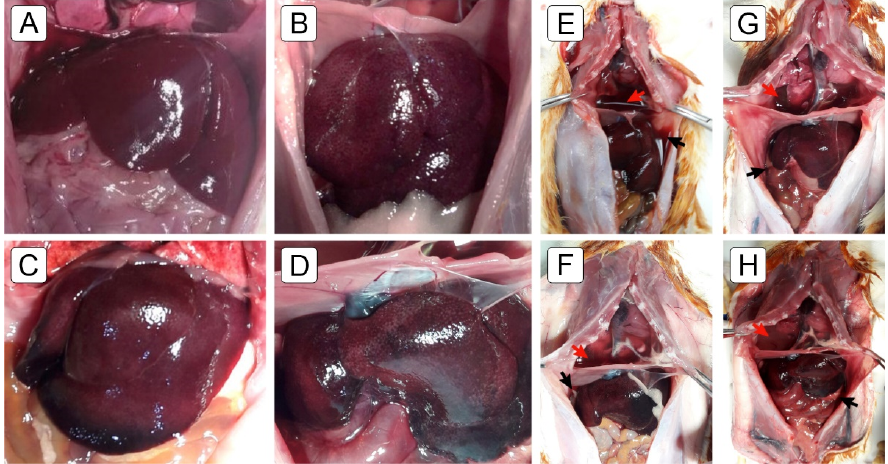
Figure 2. Gross macroscopic findings in ( A ) the normal liver of a control animal and ( B – D ) the livers of the MCT-group animals. ( B , C ) The livers of the MCT 30 and MCT 37 groups with nutmeg appearance and darkish color. In ( D ) a liver of an animal in the MCT ED group with a nutmeg-like appearance, apparent reduction in size and volume and darkish color occupying a larger area of the organ’s surface. The MCT 37 - and MCT ED -group animals showed bloody ascites (black arrows) and pericardial and pleural (red arrows) effusion ( E – H ). Int. J. Mol. Sci. 2021 , 22 , x FOR PEER REVIEW MCT-induced pulmonary arterial hypertension produced marked right ventricular hypertrophy and dilatation (Figure 3A), characterized by an increase in right ventricular free wall thickness (RVFWT) (Figure 4A) and chamber area (RVCA) (Figure 4B) in the MCT 30 and MCT 37 groups compared to the CG ( p < 0.0001).